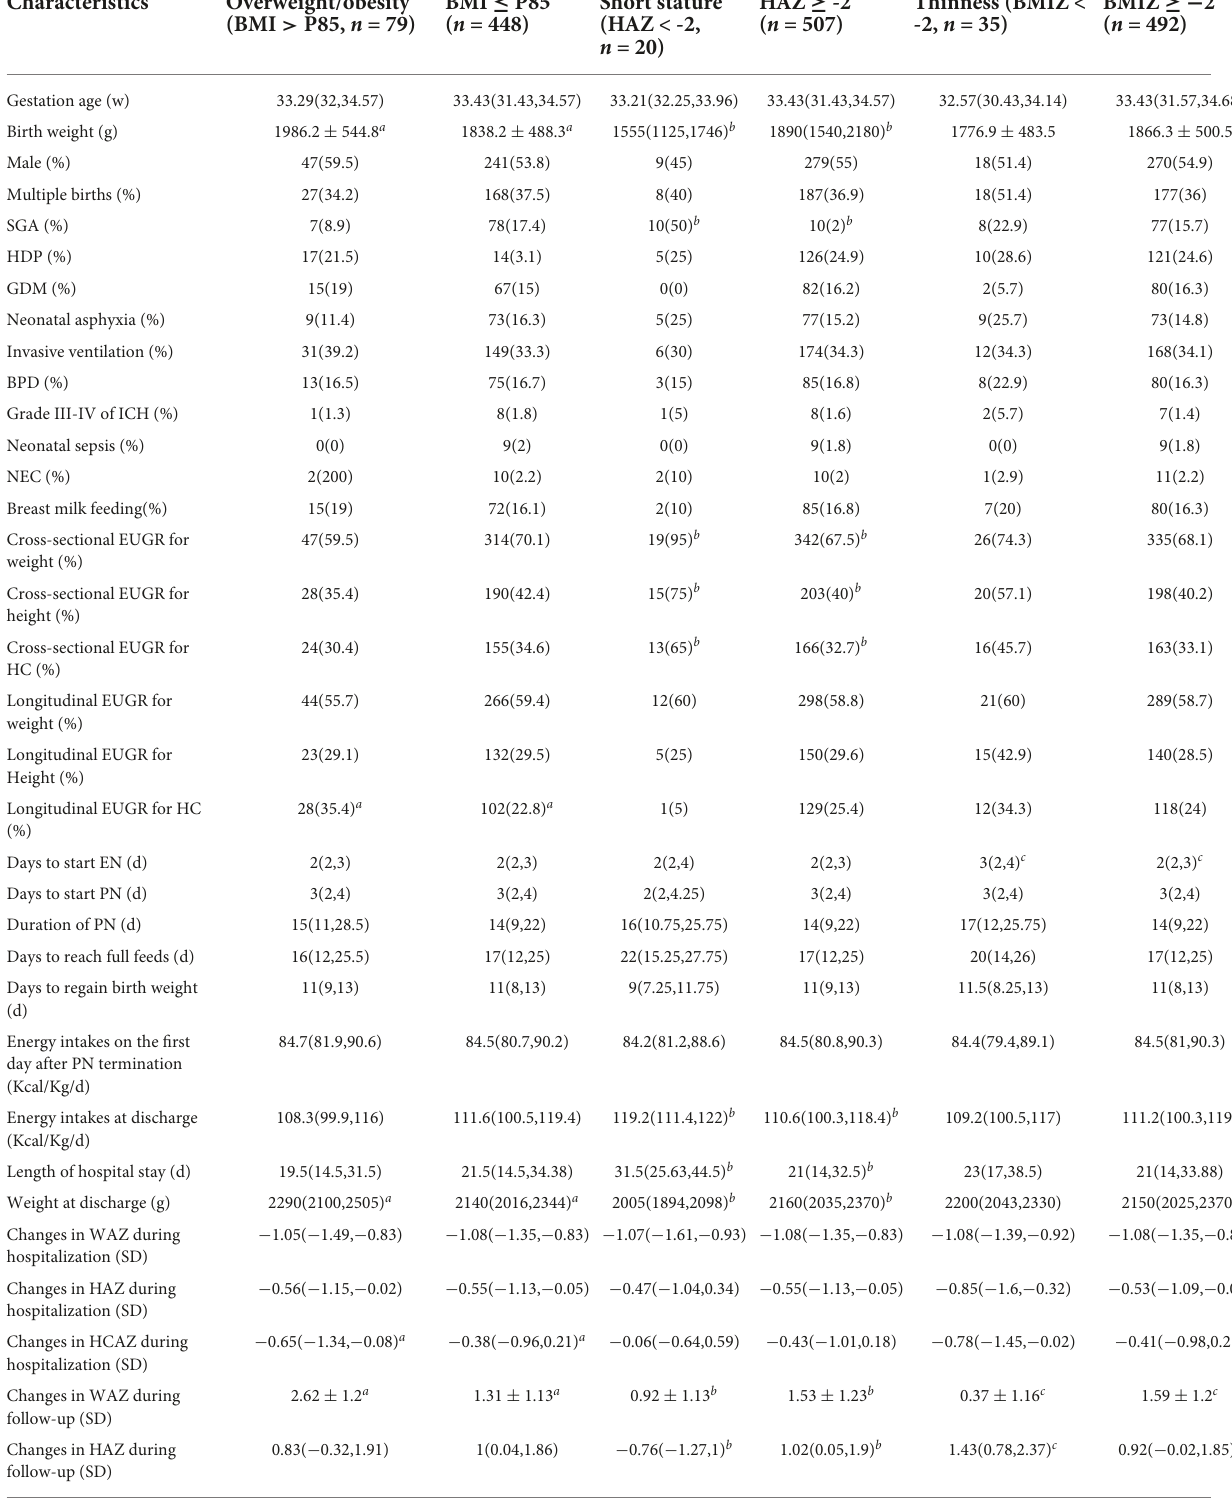
TABLE 3 Comparisons of preterm infants with or without overweight/obesity, short stature, and thinness at age 3–6 years.